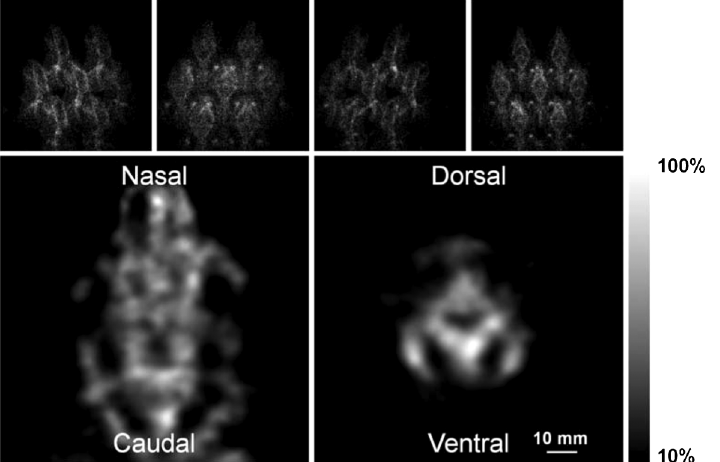
Figure 6. Bone images. Upper panels , sequence of 4 of the 16 projections obtained with the seven- pinhole imaging device of the mouse head area, labeled with 99m Tc-MDP. Lower panels , charac- teristic transversal and coronal slices through the reconstructed volumetric model of the radioactive emission from the mouse skull, after 80